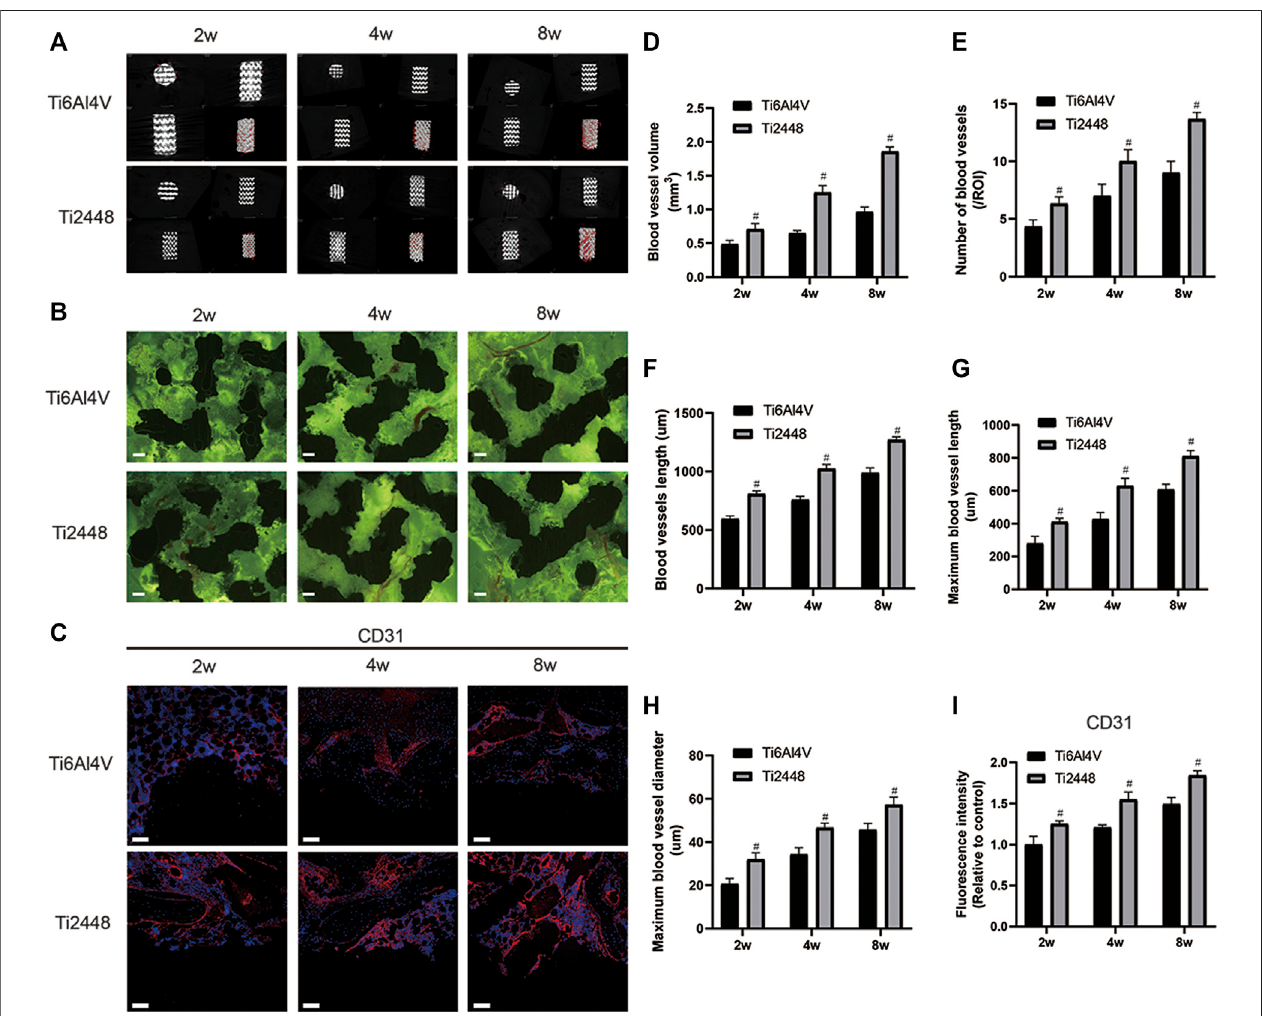
FIGURE 4 | Analysis of vascularization around and inside the scaffolds. 3D reconstruction of blood vessels around different scaffolds at 2, 4, and 8 weeks (A) . Vascularization inside the scaffolds. Scale bar (cid:2) 200 µm (B) . Immuno fl uorescence staining of CD31 in bone tissue. Scale bar (cid:2) 100 µm (C) . Quantitative analysis of vascular volume around the scaffold (D) . Quantitative analysis of the number of blood vessels inside the scaffold in a single fi eld of view (E) . Quantitative analysis of the total length of blood vessels inside the scaffold (F) . Quantitative analysis of the maximum single vessel length inside the scaffold (G) . Quantitative analysis of the maximumbloodvesseldiameterinsidethescaffold (H) .Quantitativeanalysisofthe fl uorescenceintensityofCD31aroundthescaffold (I) .Note: # p ＜ 0.05comparedto Ti2448.